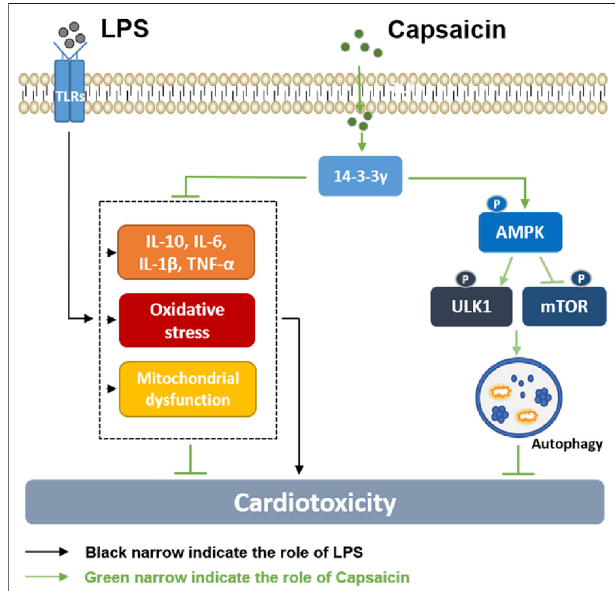
FIGURE 8 | Diagram showing the possible mechanism by which Cap alleviates LPS-induced cardiotoxicity. LPS-induced cardiotoxicity was manifested in activating in fl ammatory cytokines, producing excess oxygen radicals, and causing mitochondrial damage. The negative effects of LPS on cardiomyocytes are reversed by Cap, and the underlying mechanism may be involved in Cap-mediated 14-3-3 γ expression and autophagy regulation via the AMPK-mTOR/ULK1